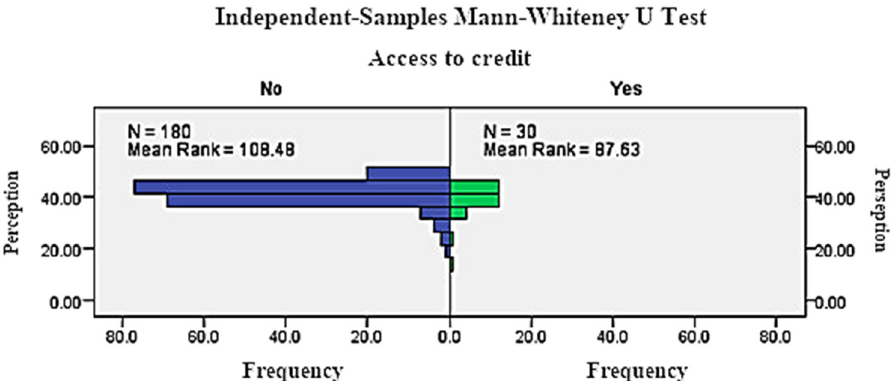
Figure 4: Comparative histogram of distribution of perceptions on the potential of SFT based on the access to credit